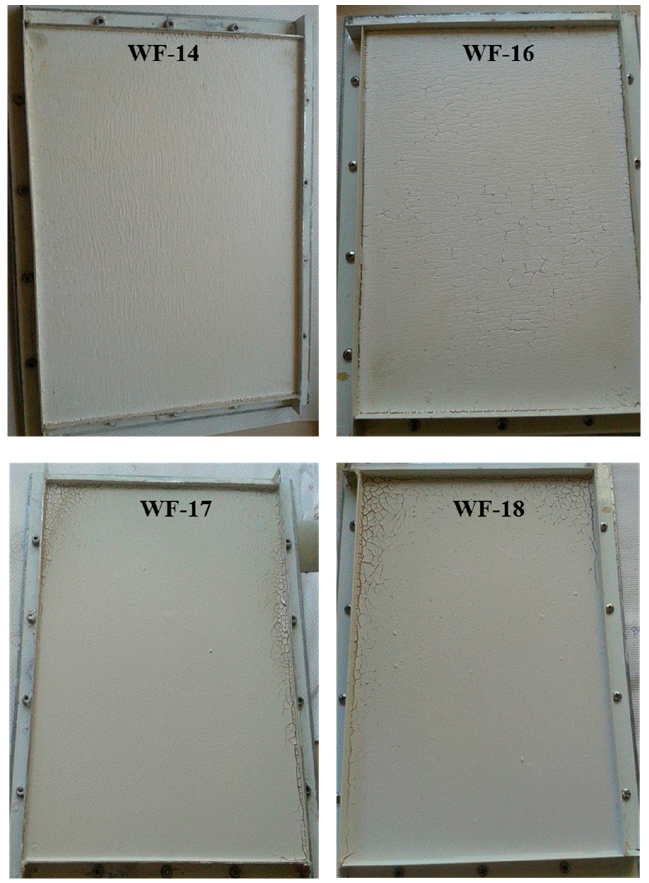
Figure 4. Photos of the optimized coatings with H5 and H5-m on wood substrates.